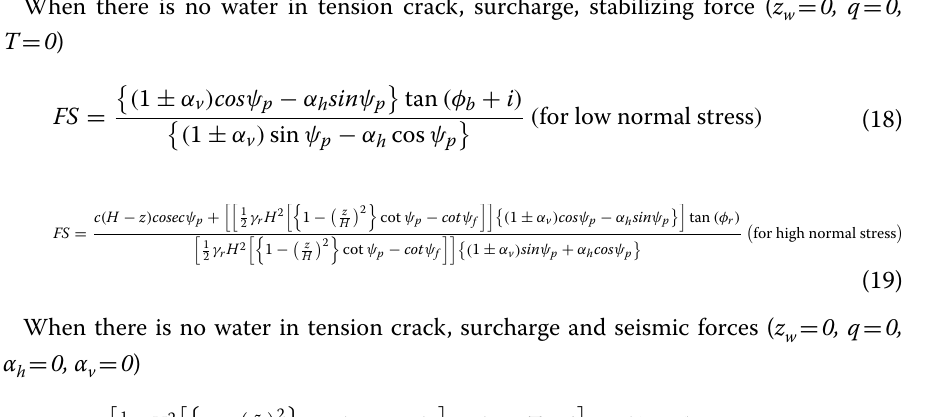
When there is no water in tension crack, surcharge, stabilizing force ( z w T 0 ) =